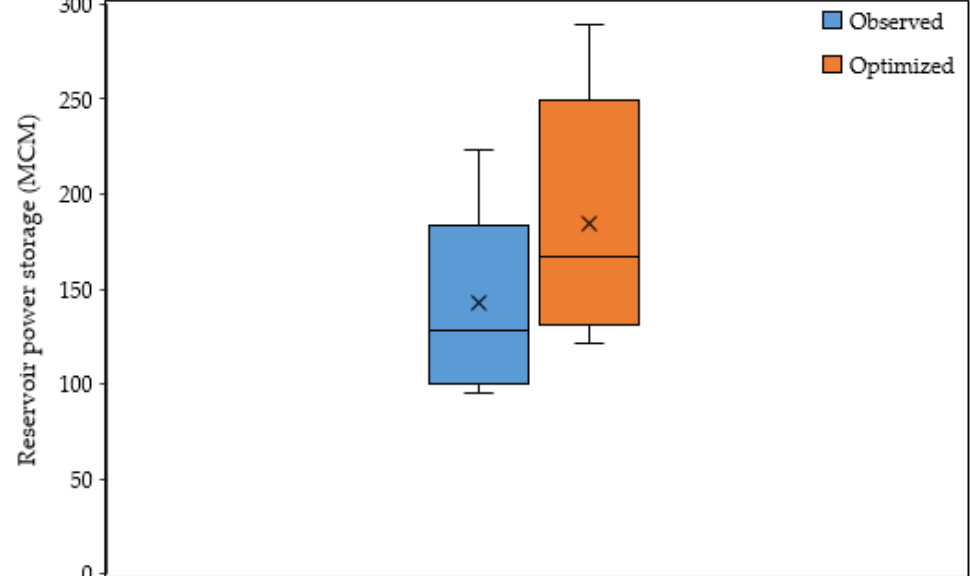
Figure 7. Average monthly current observed and optimized power storage of the Nashe reservoir.